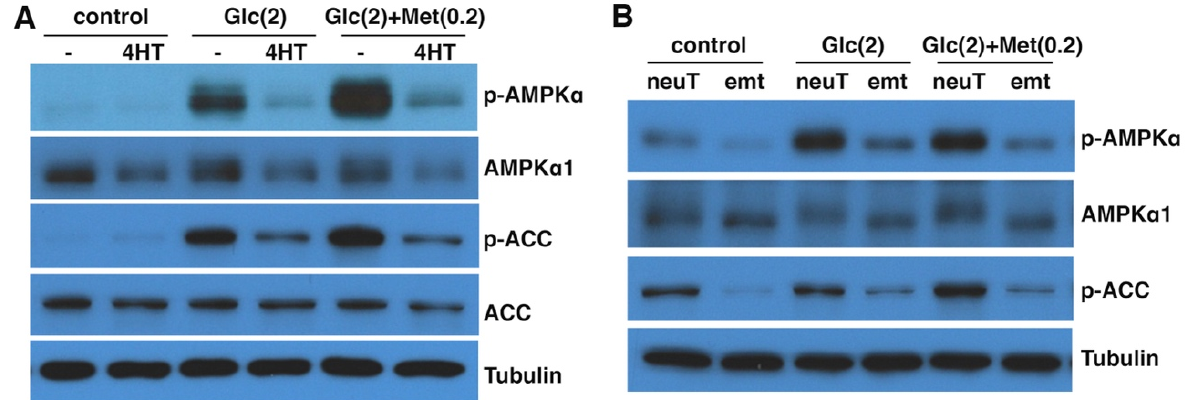
Figure 5. EMT suppresses AMPK activation by energy stress. ( A ) DCIS-Snai1-ER cells were treated with vehicle or 4HT for 2 days, then placed in normal (control) or low-glucose (Glc) media ± metformin (Met) for 6 h, followed by immunoblotting for phospho- or total AMPK α and ACC. ( B ) NeuT and neuTemt cells were under normal (control) or low glucose (Glc) media ± metformin (Met) for 6 h, then subjected to immunoblotting. Numbers in parentheses indicate concentrations (in mM). p -AMPK α : T172-phospho AMPK α . p -ACC: S79-phospho ACC. Glutamine levels in low-glucose media in ( A ) and ( B ) were 2 and 0 mM,